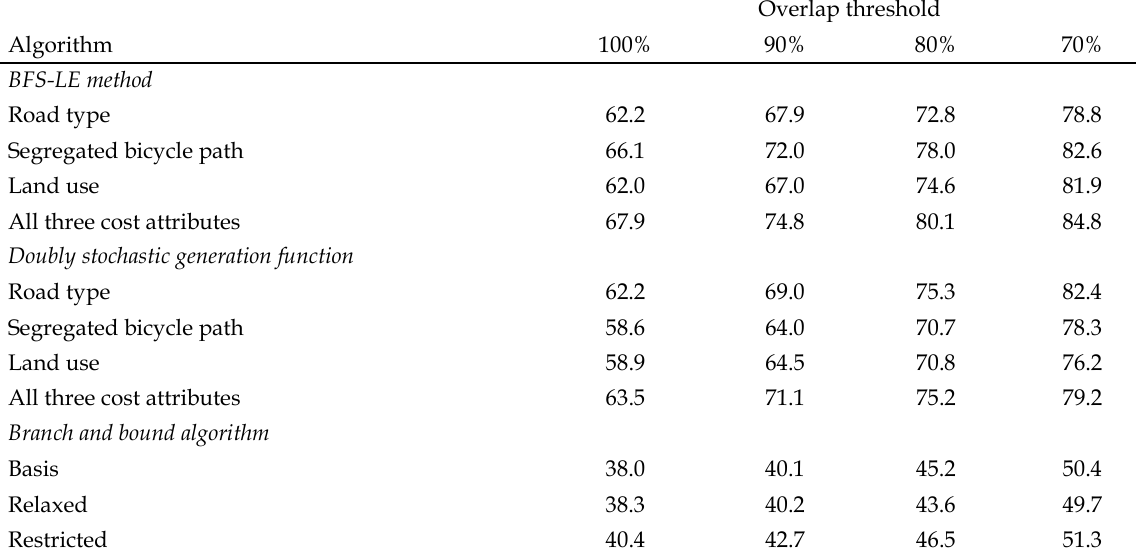
Table 3. Coverage measures of the applied